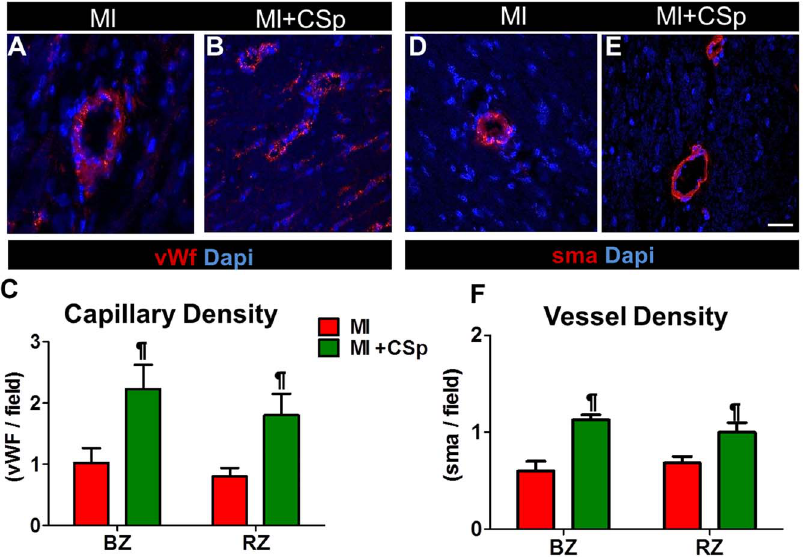
Figure 3. Cardiospheres stimulate angiogenesis. (A,B) Photomicrographs of vWf (red) stained capillaries and (D,E) smooth muscle actin (red) vessels in the border zone of CSp transplanted and vehicle treated animals. 10–15 images from the peri infarct and remote area per section were evaluated. For quantification both small and large capillaries were evaluated. (C) Quantification of the capillary density and (F) of the vessels’ density in both border and remote regions. Significant increases in both structures were detected post CSp transplantation in both regions studied. Five different heart tissues per group were analyzed. Abbreviations. IZ (infarct zone), BZ (border zone), RZ (remote zone). (Scale bars 50 m m). Data are mean 6 SD. " p , 0.05 control vs. MI + CSp.